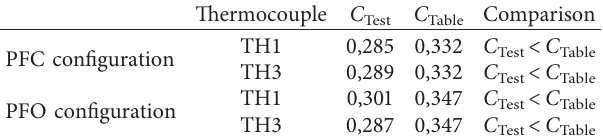
Table 2: Results obtained from Cochran’s test.